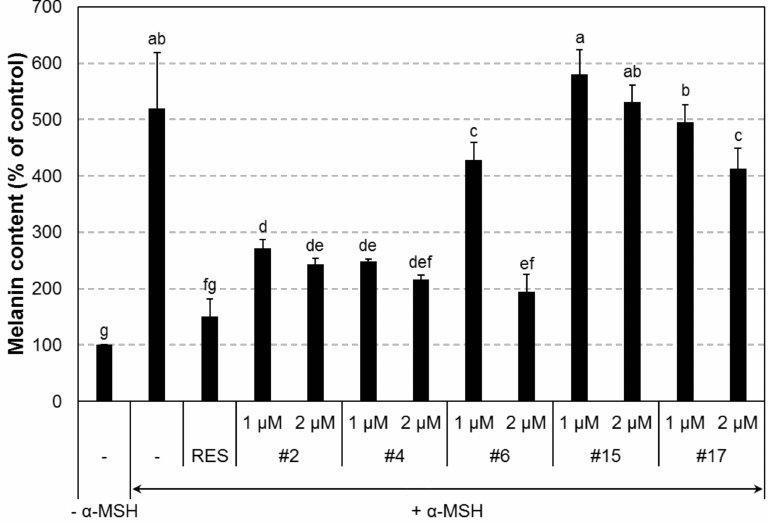
Figure 2. In vitro anti-melanogenic activity of compound #2 , #4 , #6 , #15 , and #17 . B16F10 cells were cultured in the presence of various compounds at 1 or 2 µ M concentration and/or α -MSH at 10 nM for 72 h. Cellular melanin content decreased following treatment with these compounds in a dose-dependent manner. α -MSH, alpha-melanocyte-stimulating hormone (10 nM). RES, resveratrol (10 µ M). n = 3; error bars, mean ± SEM. Different alphabetical letters indicate significant differences among the conditions ( p < 0.05).